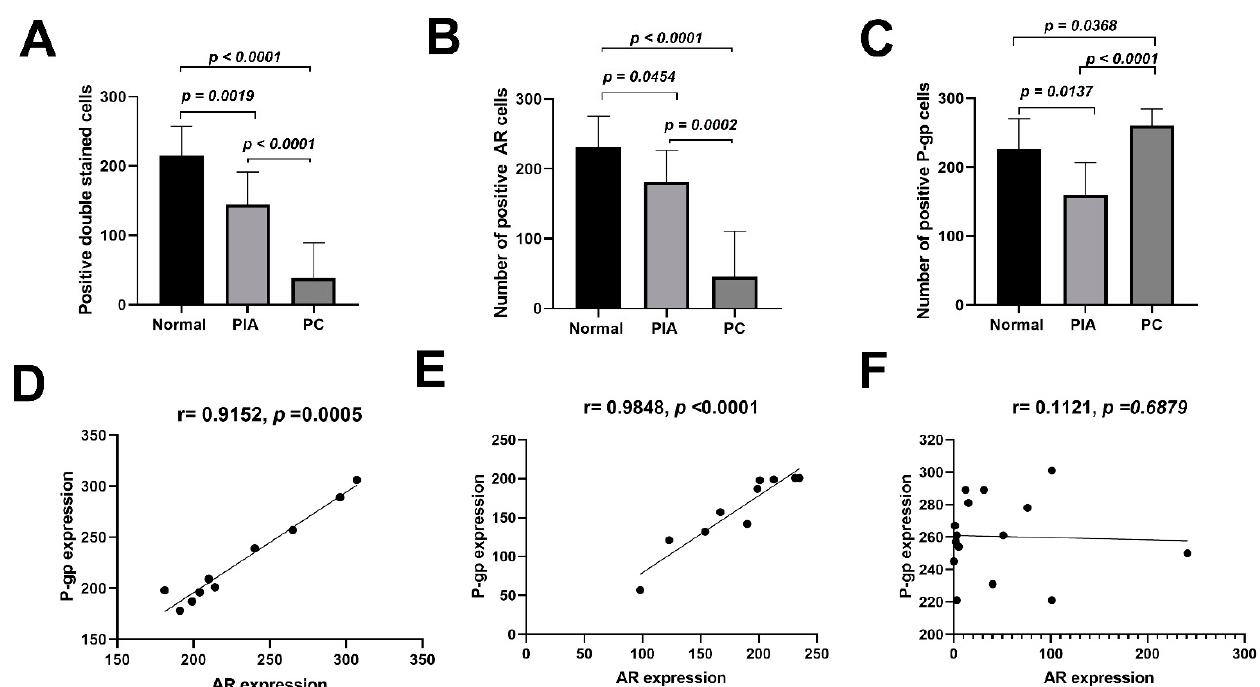
Figure 1. Expression of androgen receptor (AR), P-glycoprotein (P-gp) and doubled stained cells (AR/P-gp) in canine prostatic samples. ( A ): Analysis of variance (ANOVA) revealing high doubled stained cells (AR/P-gp) in normal samples and decreased expression on proliferative inflammatory atrophy (PIA) and prostate cancer (PC) samples. ( B ): High AR expression in normal samples compared to PIA and PC. ( C ): ANOVA analysis revealing higher P-gp expression on PC samples, compared to normal and PIA. ( D ): Positive correlation between the number of AR and P-gp positive stained cells in normal samples, indicating a dependency of both variables. Therefore, in normal prostate, increased AR expression also increases P-gp expression. ( E ): Correlation analysis revealing that samples with higher AR expression also demonstrate higher P-gp expression in PIA samples. Similar to normal samples, in PIA samples, AR and P-gp expression presents dependency, indicating control of P-gp to androgen hormones influx. ( F ): No correlation is found between AR and P-gp expression in PC samples. Thus, in canine PC, no dependency or relation is detected between AR and P-gp expression.